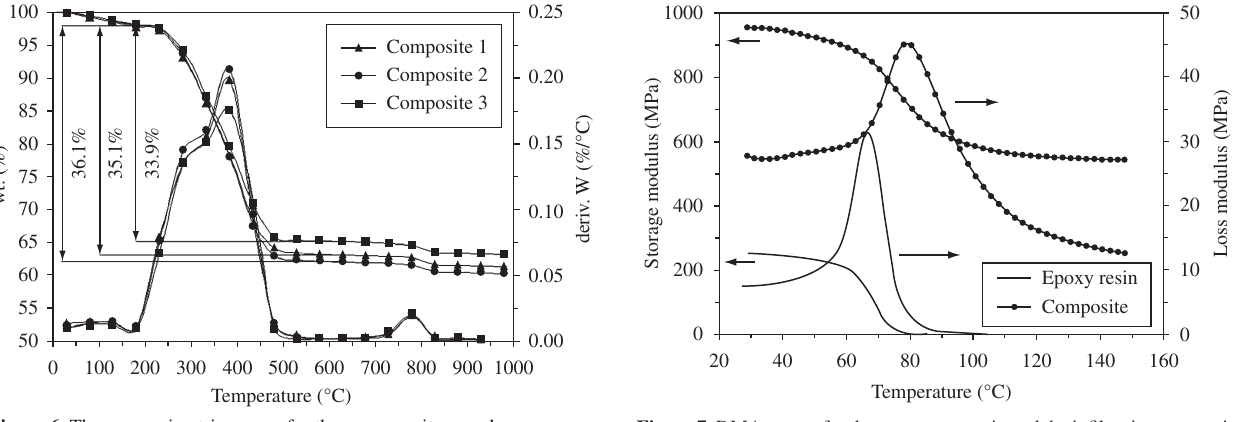
Figure 6. Thermogravimetric curves for three composite samples. Figure 7. DMA curves for the neat epoxy resin and the infiltration composite